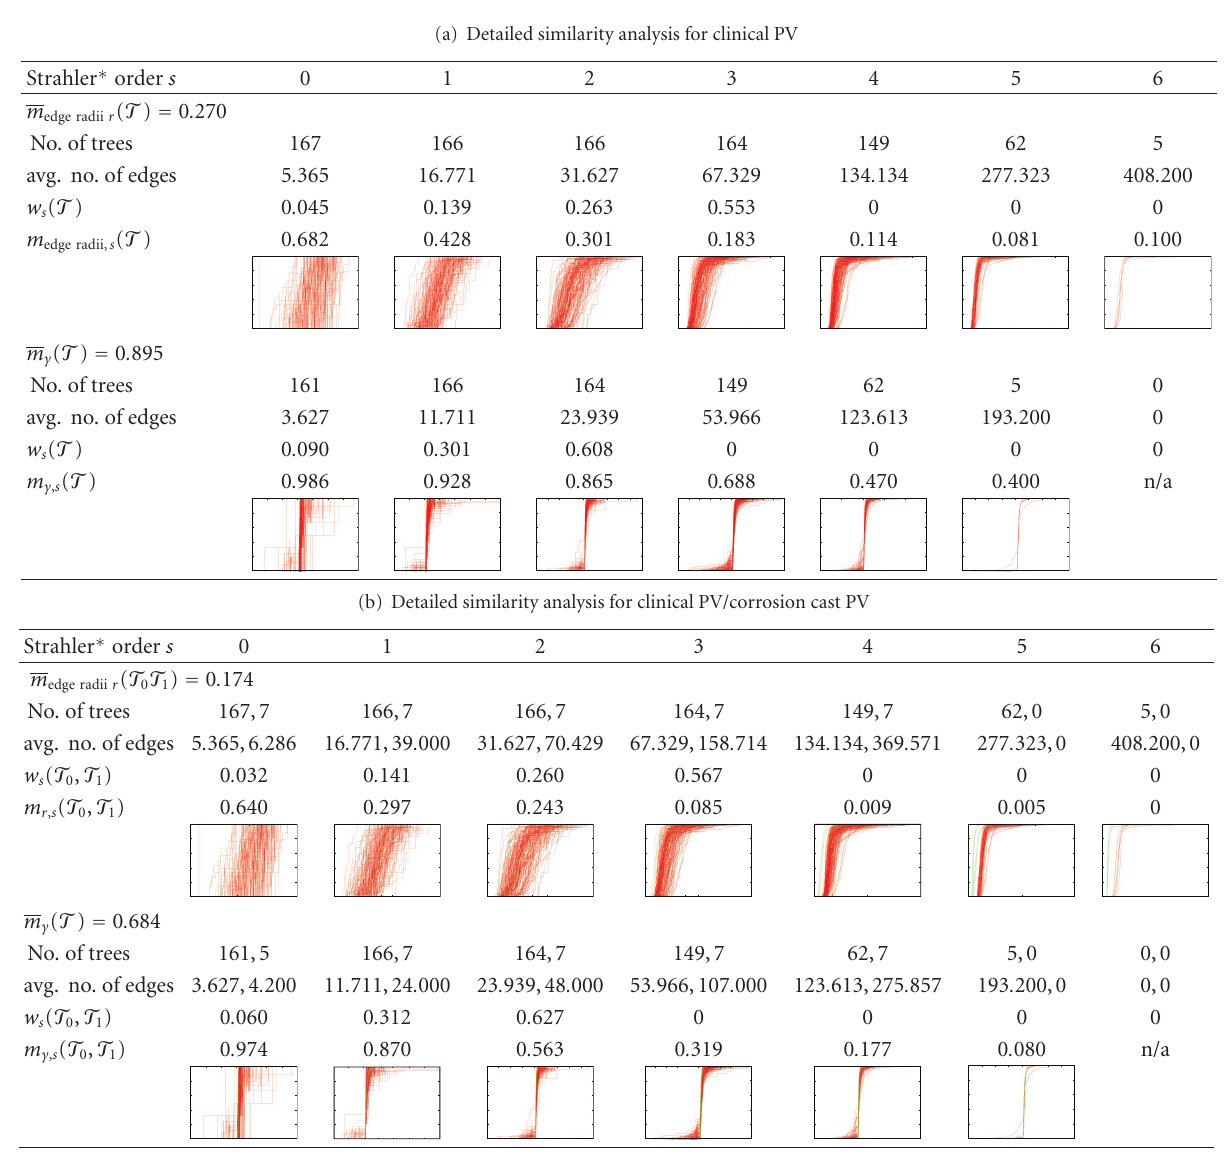
Table 4: The tables show the invariance analysis for two example features, edge radii and the bifurcation exponent γ . In (a), we consider the one-population case of clinical PV, and (b) treats the two-population case clinical versus corrosion cast PV. The average number of trees as well as the average number of edges per tree is those considered for the respective feature and may thus vary due to geometric degeneracies. We moreover list the averaging weights w s from (3) and (5), respectively, to determine the average invariance m from the individual invariances m f , s for the di ff erent Strahler ∗ orders s . The plots show the empirical cumulative distribution functions of the features, red for the clinical and green for the corrosion cast data